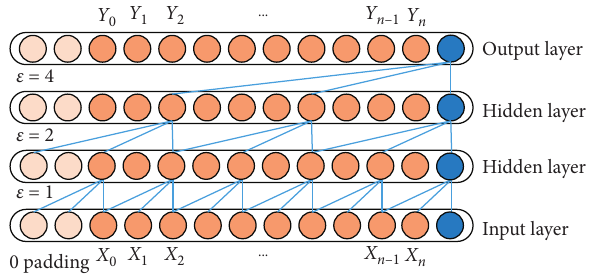
Figure 2: TCN structure